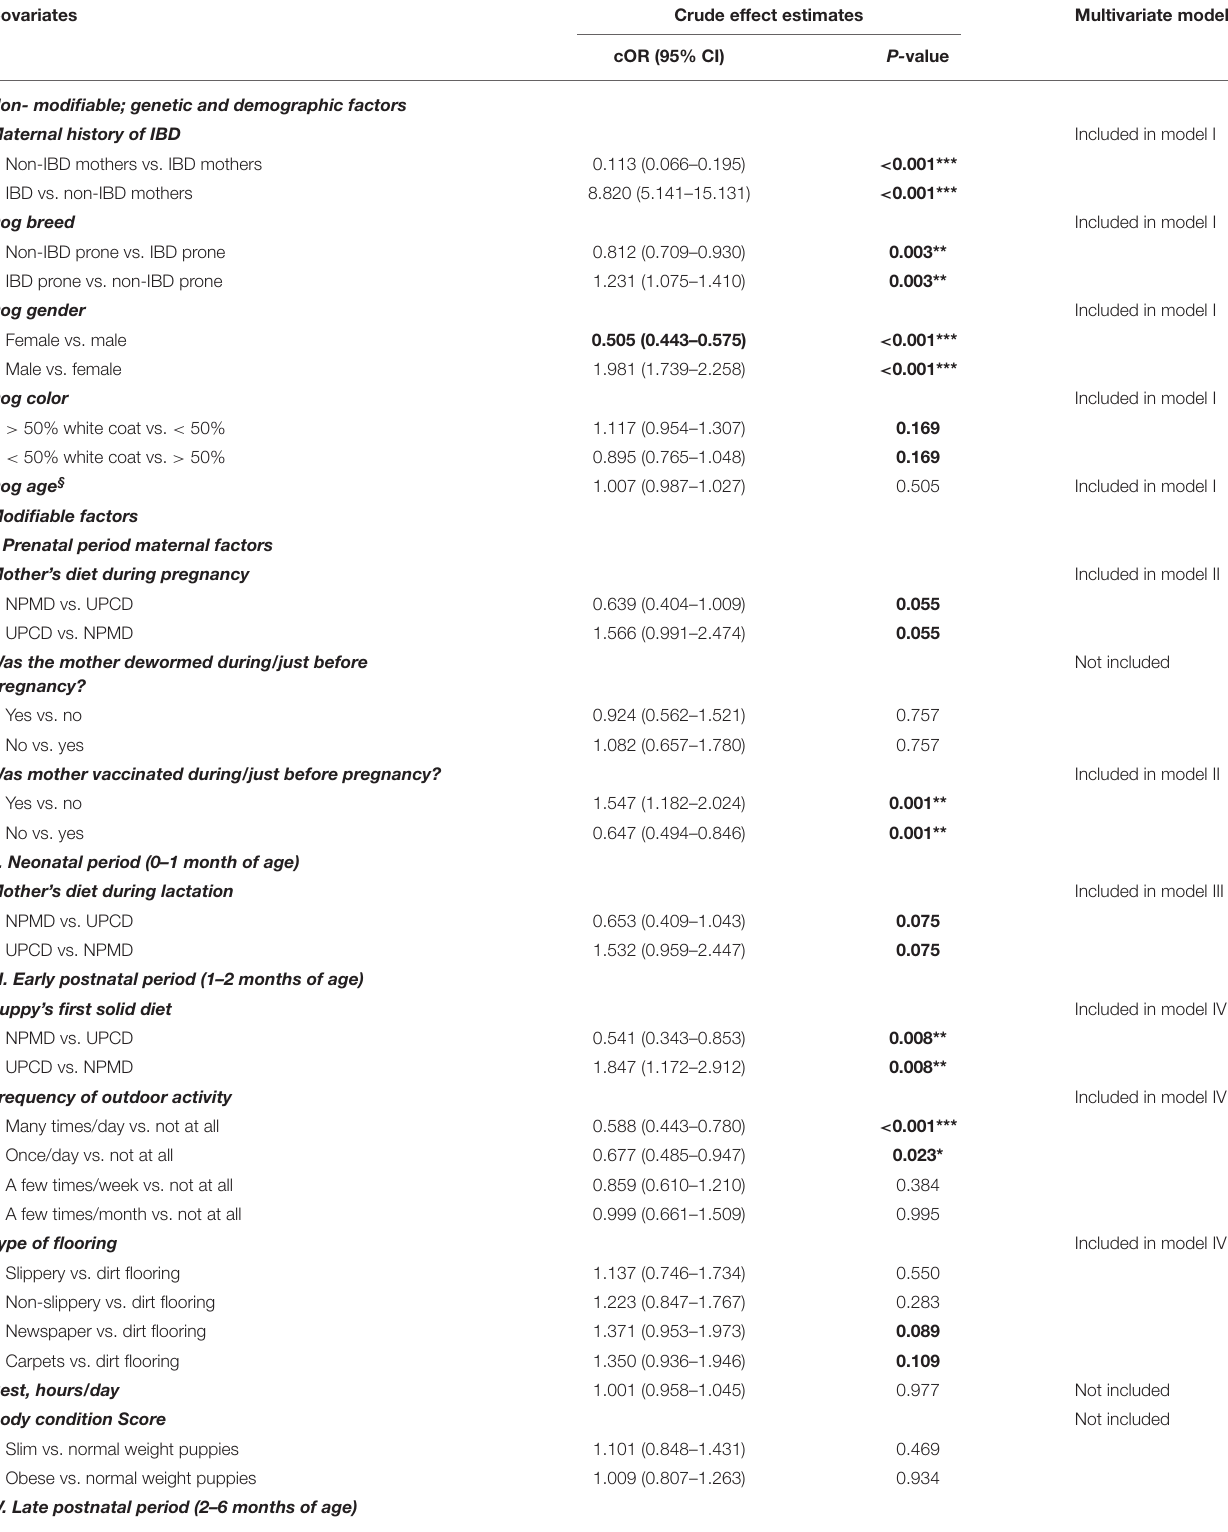
TABLE 3 | Associations of early life covariates with inflammatory bowel disease in dogs based on univariate logistic regression analyses.